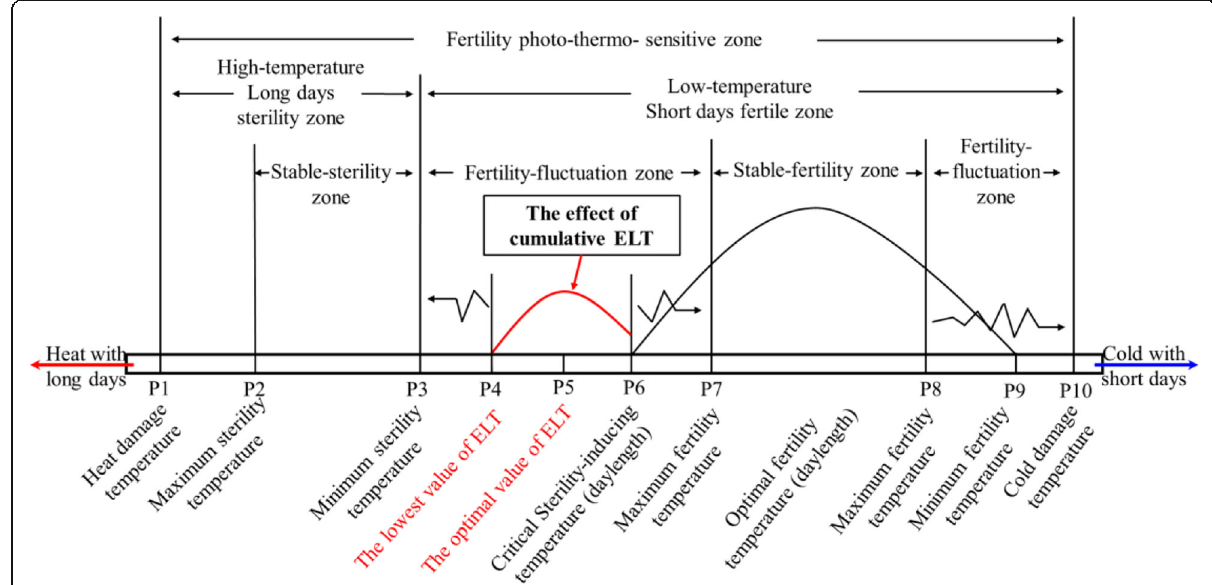
Fig. 3 General scheme of the fertility transition for two-line male sterile rice. The position of red-colored section (from P4 to P6) was modified (added) according to Yao et al. (1995). The horizontal bars represent temperature and day length. The zig-zag lines and the red arrow indicate that the interval lengths between P4 and P3, P6 and P7, P8 and P9, and P4 and P6, respectively, fluctuate due to the changes of photo-thermo- conditions, which constitute the “ sterility-fluctuation zone ” . P6 indicates the CSIT (daylength). The transition from P6 to P9 corresponds the stable- fertility zone under optimal photo-thermo-conditions while the transition from P3 to P2 corresponds to the stable-sterility zone due to high temperatures and long days. The transition from P9 to P10, or from P2 to P1 is not recommended for self-pollination (propagation) or hybrid seed production because of the extremely low or high temperature, respectively. The transition from P4 to P6, which was not reported by Yao et al. (1995), is the zone of the effect of cumulative ELT which may explain the fertility restoration observed in two-line male sterile rice under ALT (The DAT of the ALT is higher than the CSIT of two-line male sterile rice, but the nighttime temperature is lower than the